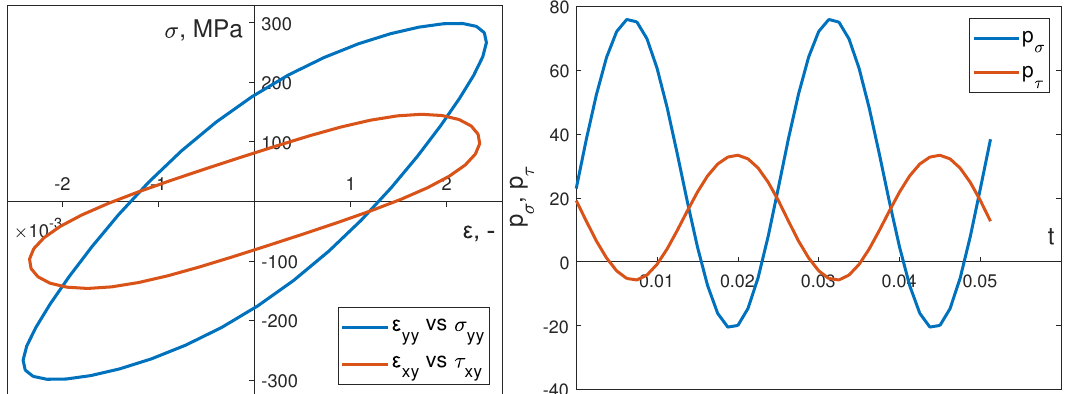
Figure 10. Stabilized calculated hysteresis loops for kinematic out-of-phase load and calculated instantaneous power (bending) p σ and torsion p τ .